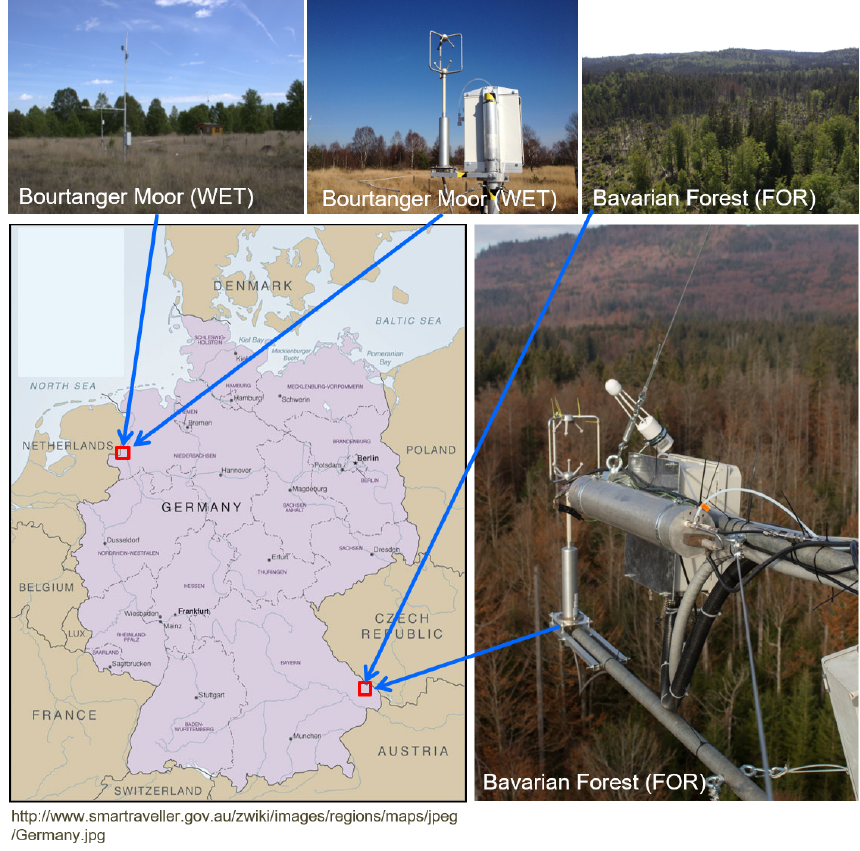
Figure 1. Map of campaign locations and setup pictures.